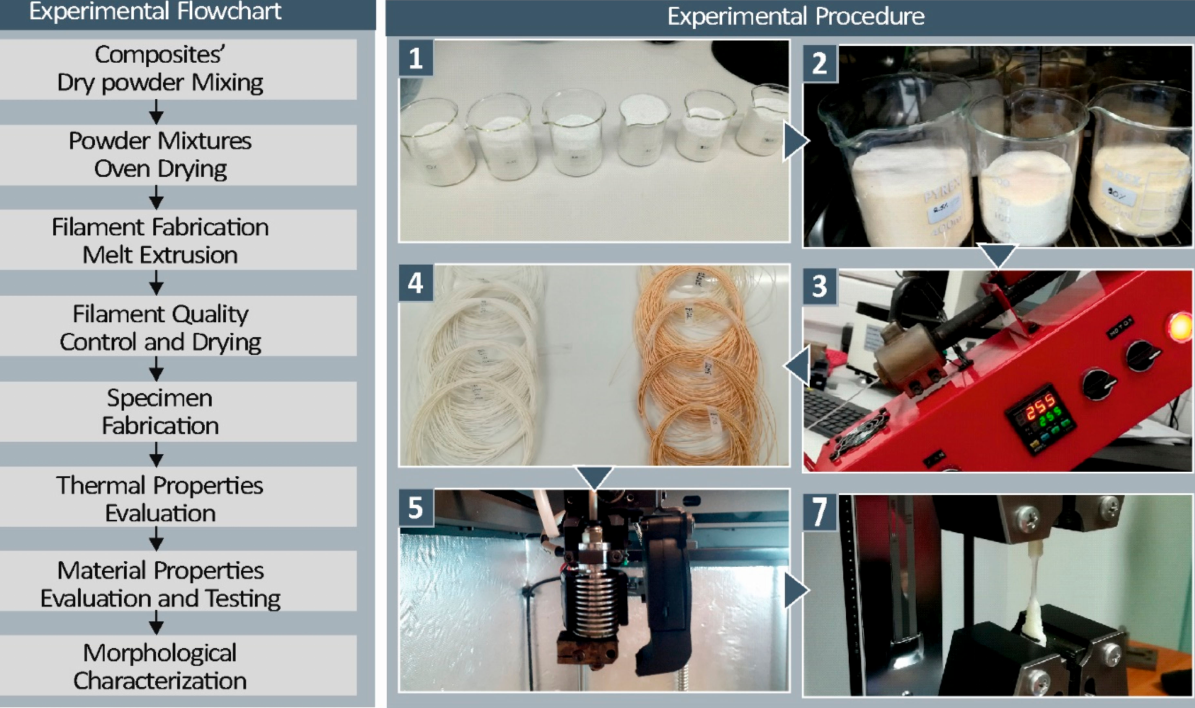
Figure 1. Workflow methodology that was followed in this